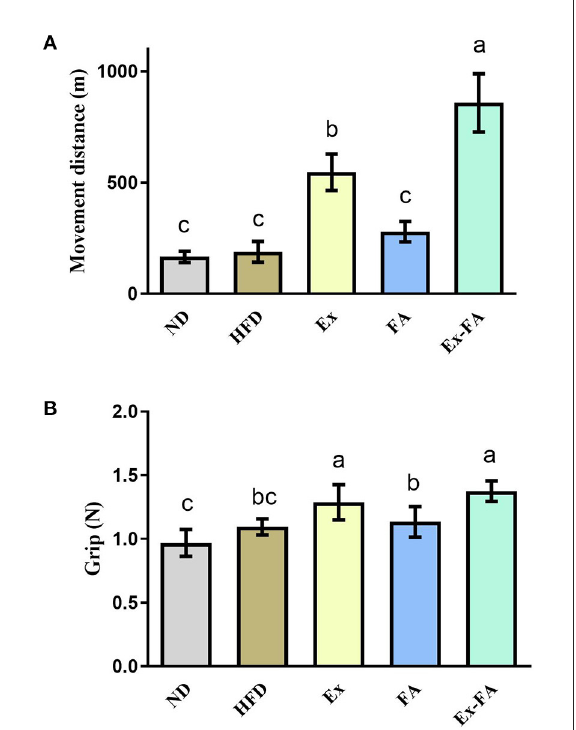
FIGURE3 Effects of Ex, FA, and Ex-FA on exercise performance in HFD-fed mice. (A) Movement distance; (B) Grip strength. ND, normal diet group (control); HFD, high-fat diet group (model); Ex, high-fat diet with exercise; FA, high-fat diet with ferulic acid; Ex-FA, high-fat diet with exercise and ferulic acid. Data are expressed as mean ± SD ( n = 4 for movement distance and n = 10 for grip strength). Means with different letters are significantly different ( P <